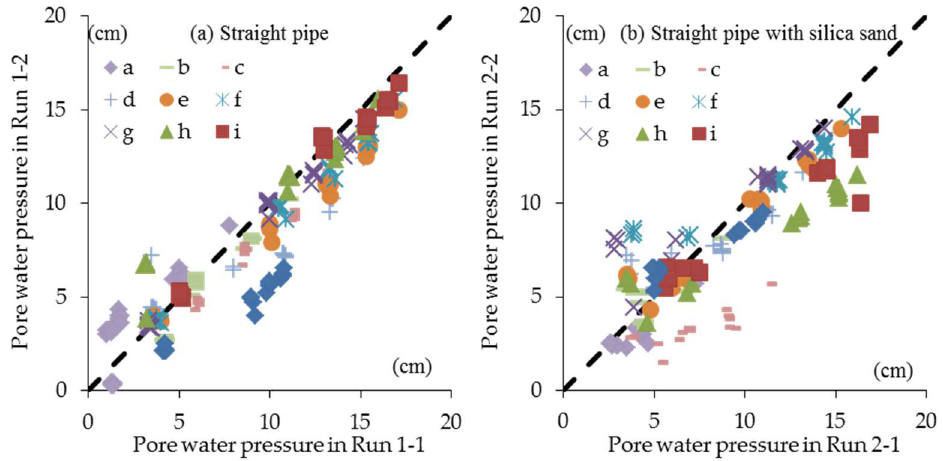
Figure 6. Comparison of pore water pressure at the same pint under the same water supply condition between Runs 1 and 2. The legend ( a , b ) indicates each manometer. The trend of each manometer was similar generally in two times.